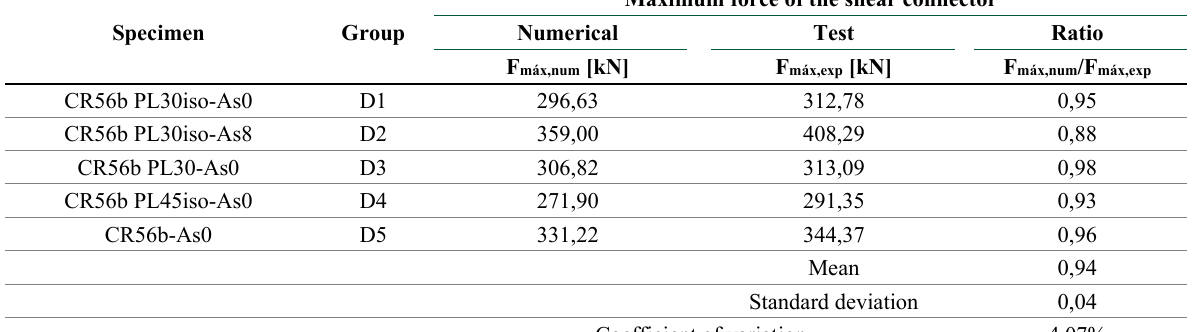
Table 2. Numerical and experimental results.